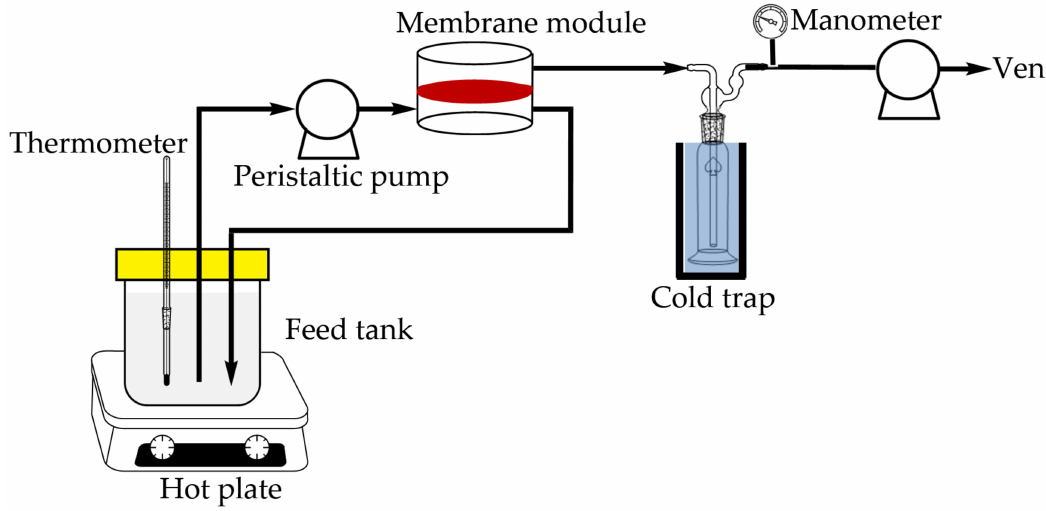
Figure 2. Experimental set-up for pervaporation